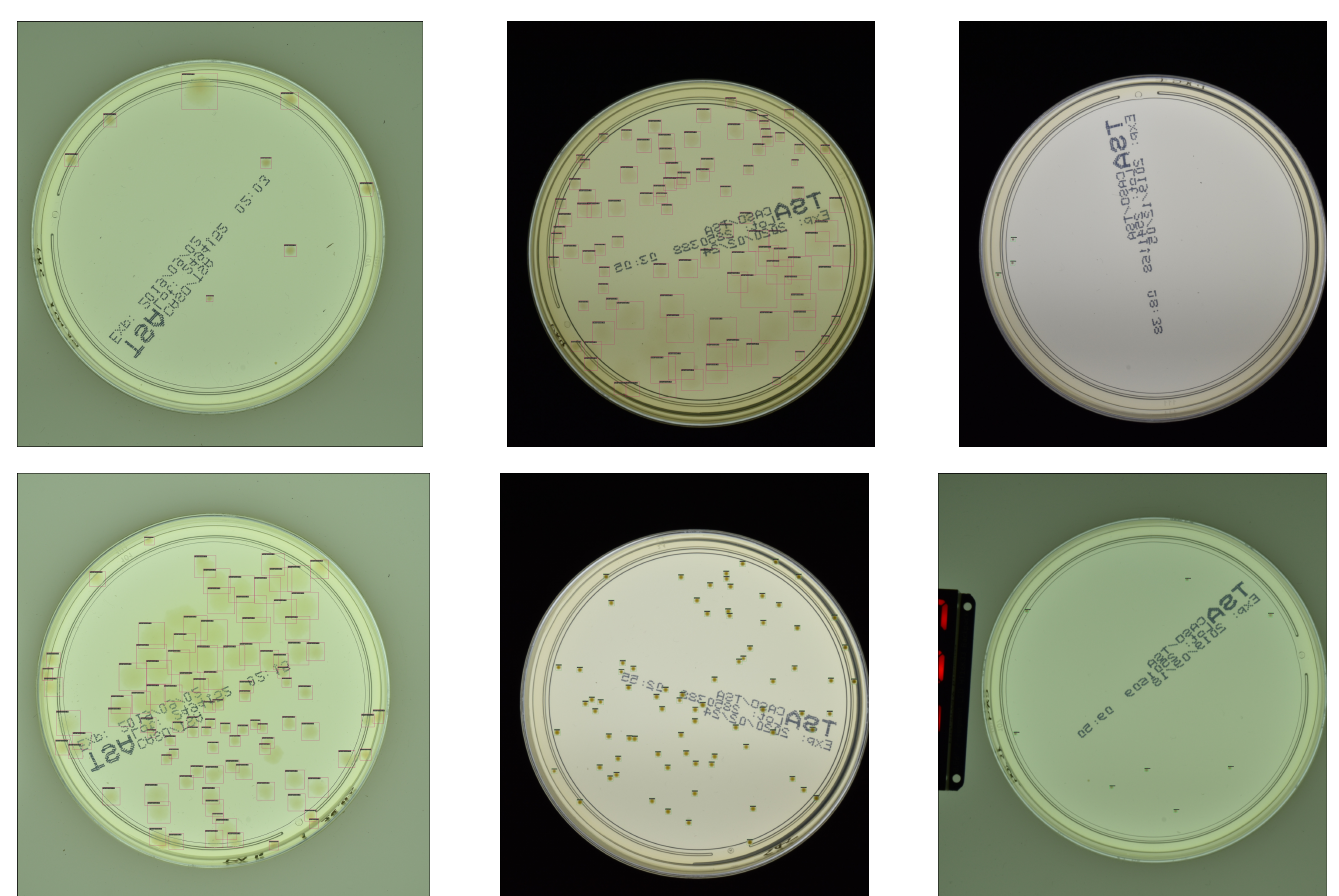
Figure A3. Examples of our PLG-ViT with Faster RCNN [55] on AGAR [45].